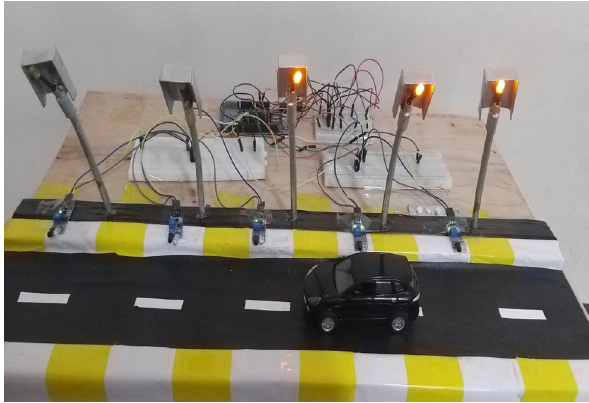
Figure 2: Switching ON of the light column nos. 1, 2, and 3, while 3 and 4 are OFF.